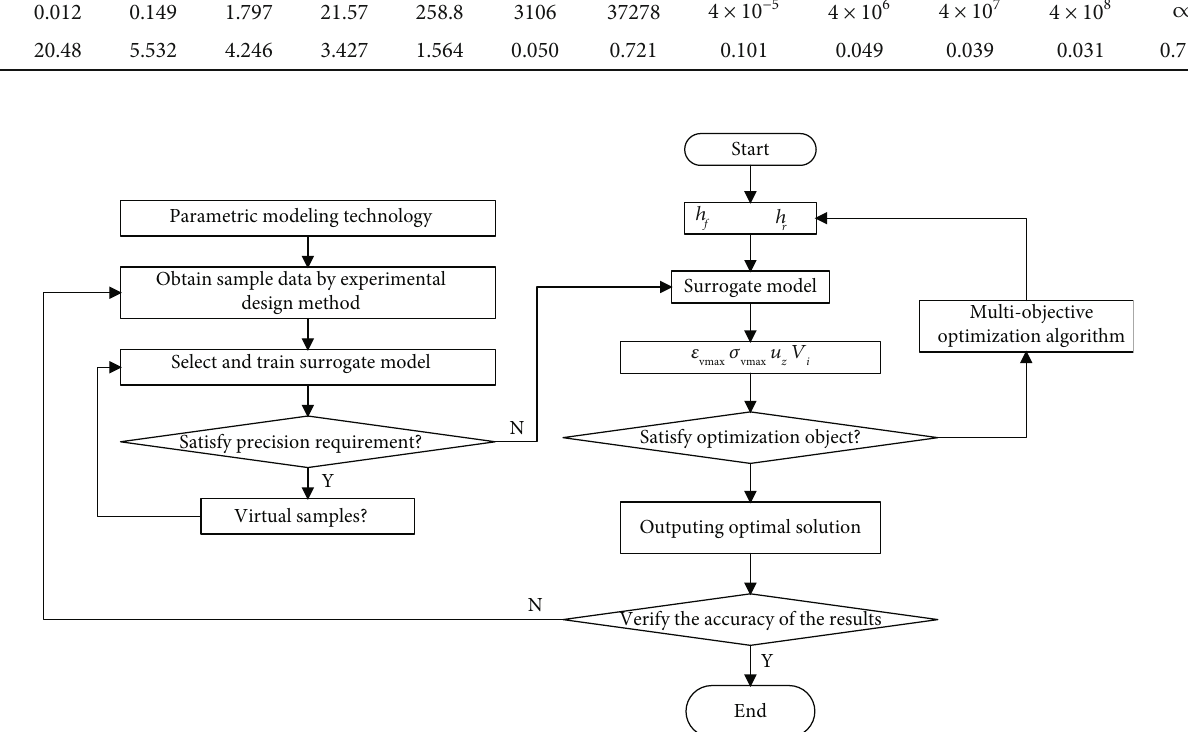
Figure 2: Flow chart of optimization based on parametric modeling technology and a surrogate